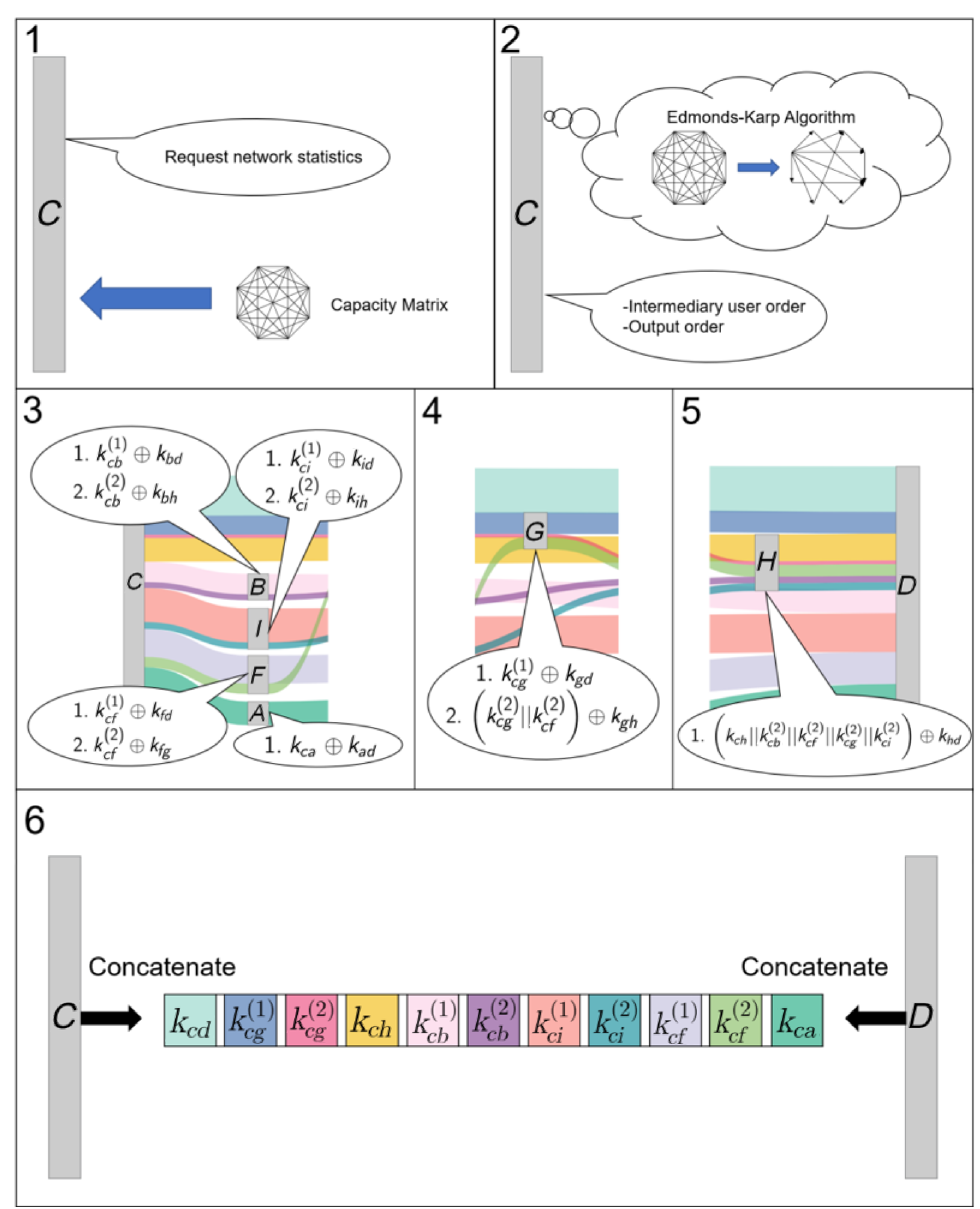
FIG. 12. Step by step implementation of our flooding protocol on the quantum network test bed : Panel 1 shows user C requesting network statistics to determine the capacity matrix of the available network resources. Panel 2 shows user C finding an optimal quantum secure flooding protocol using the Edmonds-Karp Algorithm and the capacity matrix. User C communicates to the intermediary nodes their ordering and the order in which to use their remaining keys to output their received keys. Panels 3, 4 and 5 show the announcements made by the intermediary nodes. Panel 6 shows the two end users privately concatenating their shared